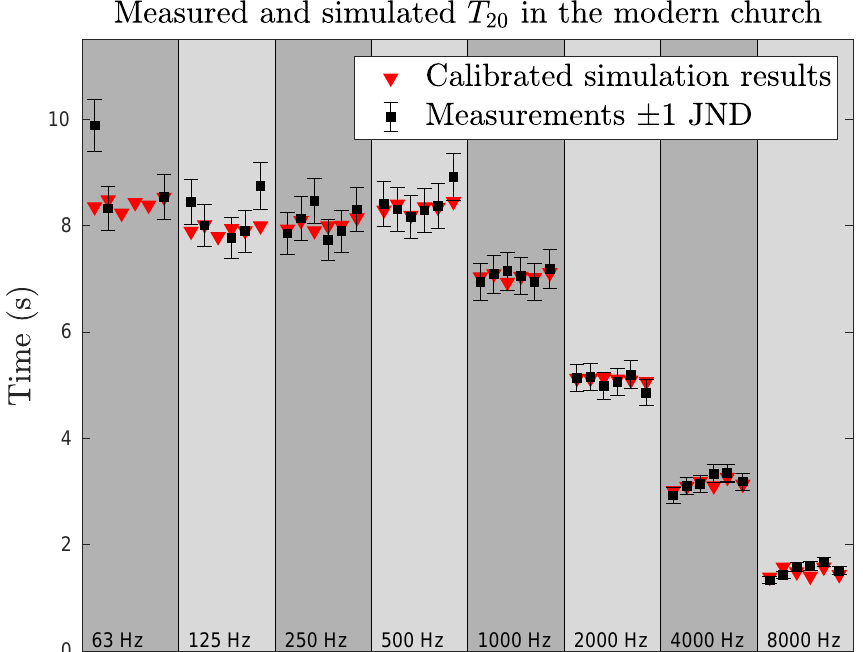
Figure 8. Comparison between simulated and measured T 20 values in the modern church. The red triangles show the results of the calibrated simulation, and the black boxes correspond to measurements together with frequency-dependent 1 JND error bars. The results for six different listener–receiver combinations are shown across center octave-band frequencies from 63 to 8000 Hz. For low frequencies, some values could not be extracted from the measurements and only the simulated results are shown. The average error in JND is highest in the 63 Hz and 8000 Hz octave bands with 1.2 and 1.4, respectively; the remaining octave bands have values between 0.2 and